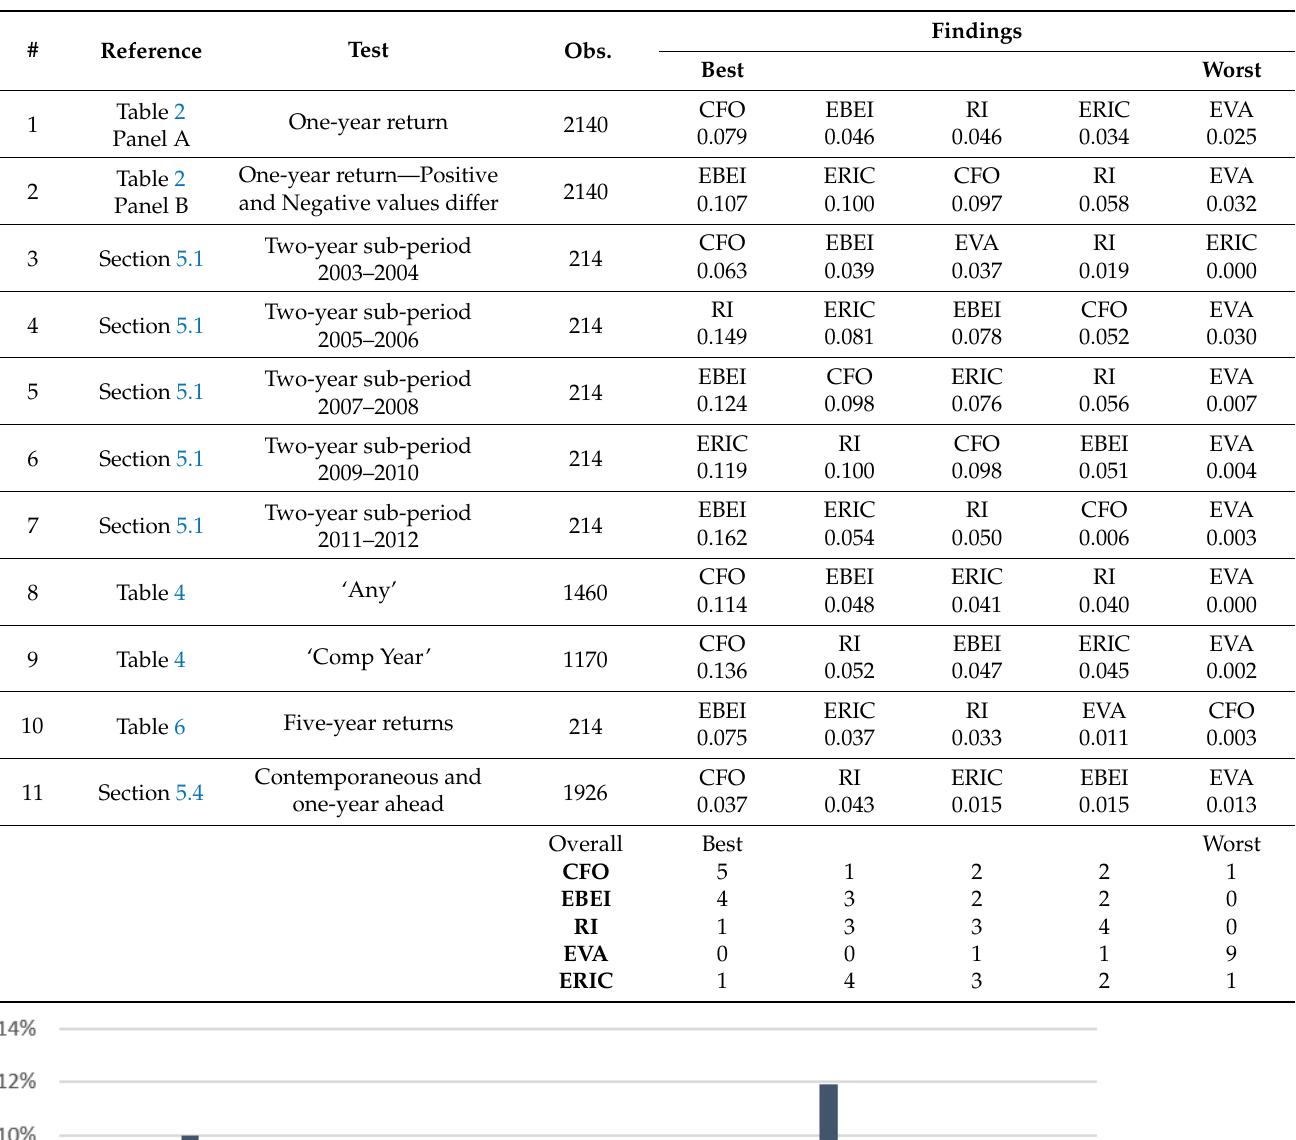
Table 7. Synthesis of the information content of